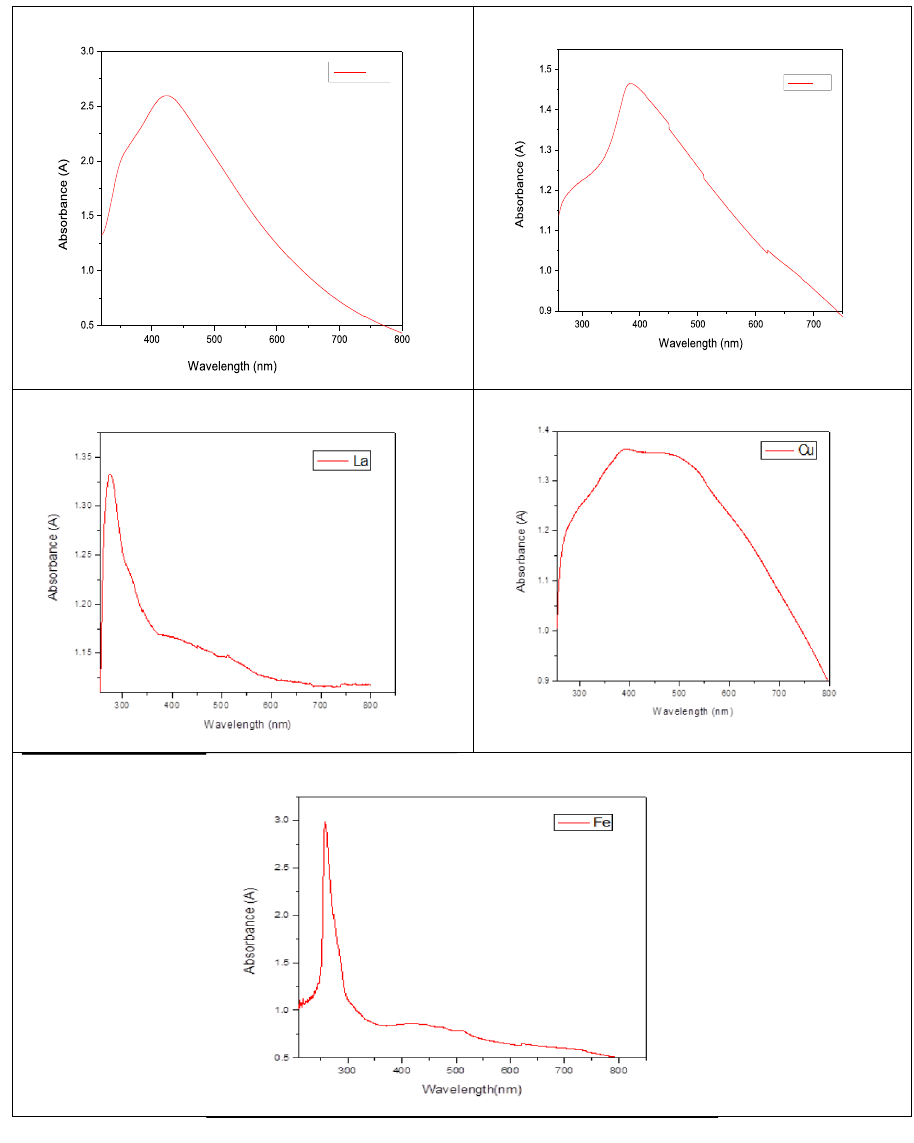
Figure 1. UV–VIS spectra of biosynthesized nanoparticles from M.